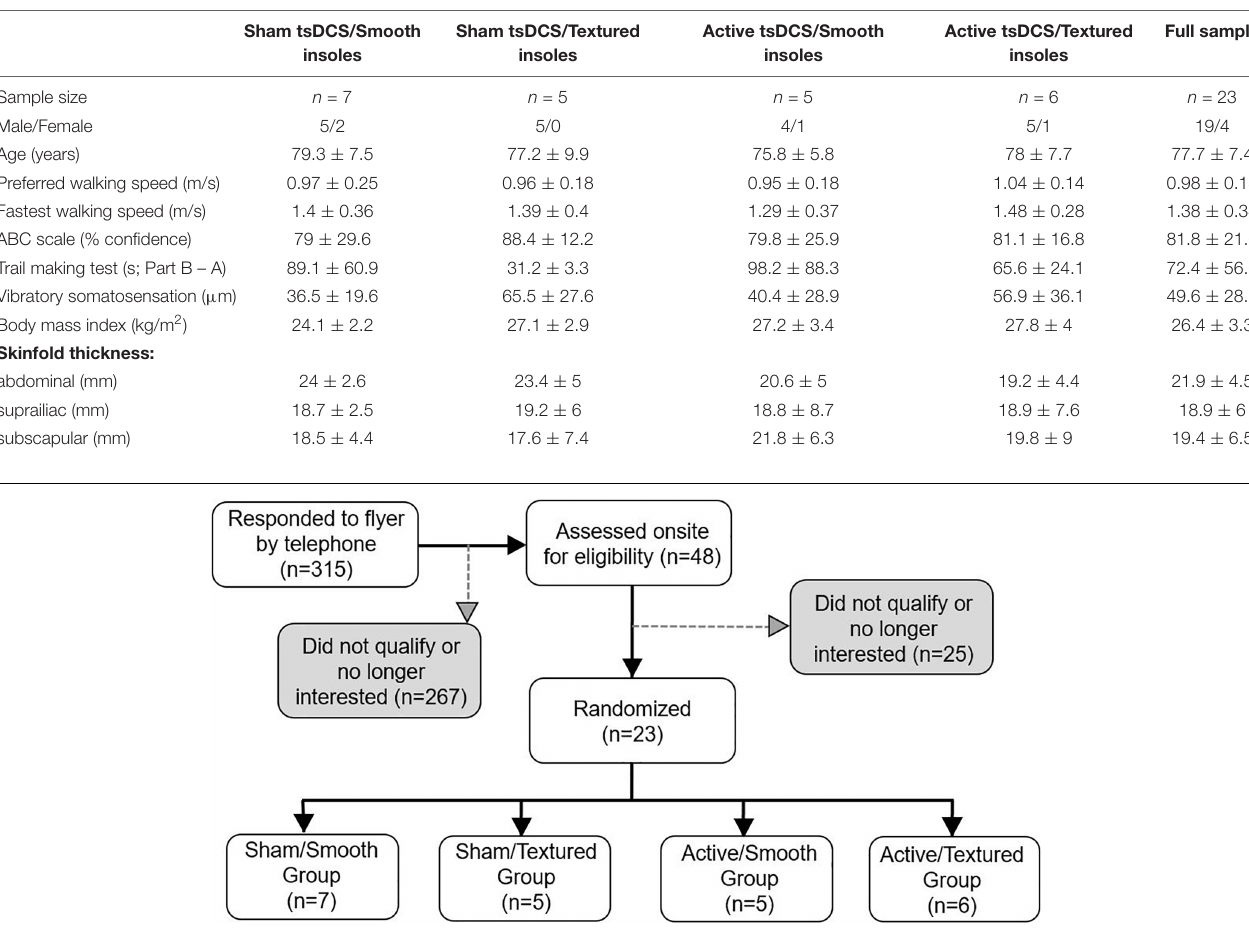
TABLE 1 | Participant demographics, clinical assessments, and walking function.